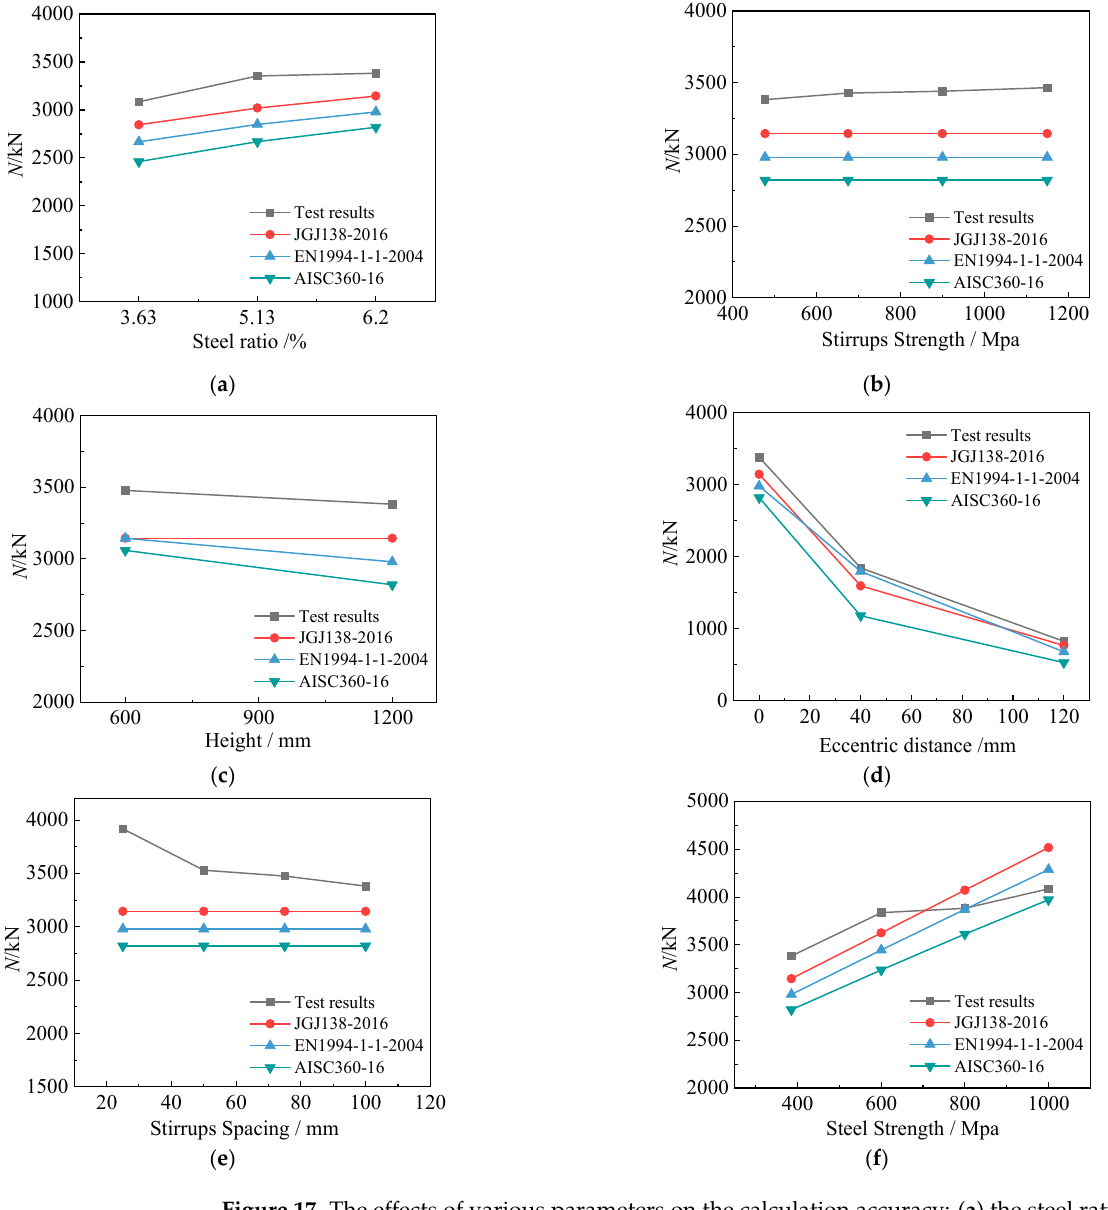
Figure 17. The effects of various parameters on the calculation accuracy: ( a ) the steel ratio; ( b ) the stirrup strength; ( c ) the height of the column; ( d ) the eccentric distance; ( e ) the stirrup spacing; ( f ) the steel